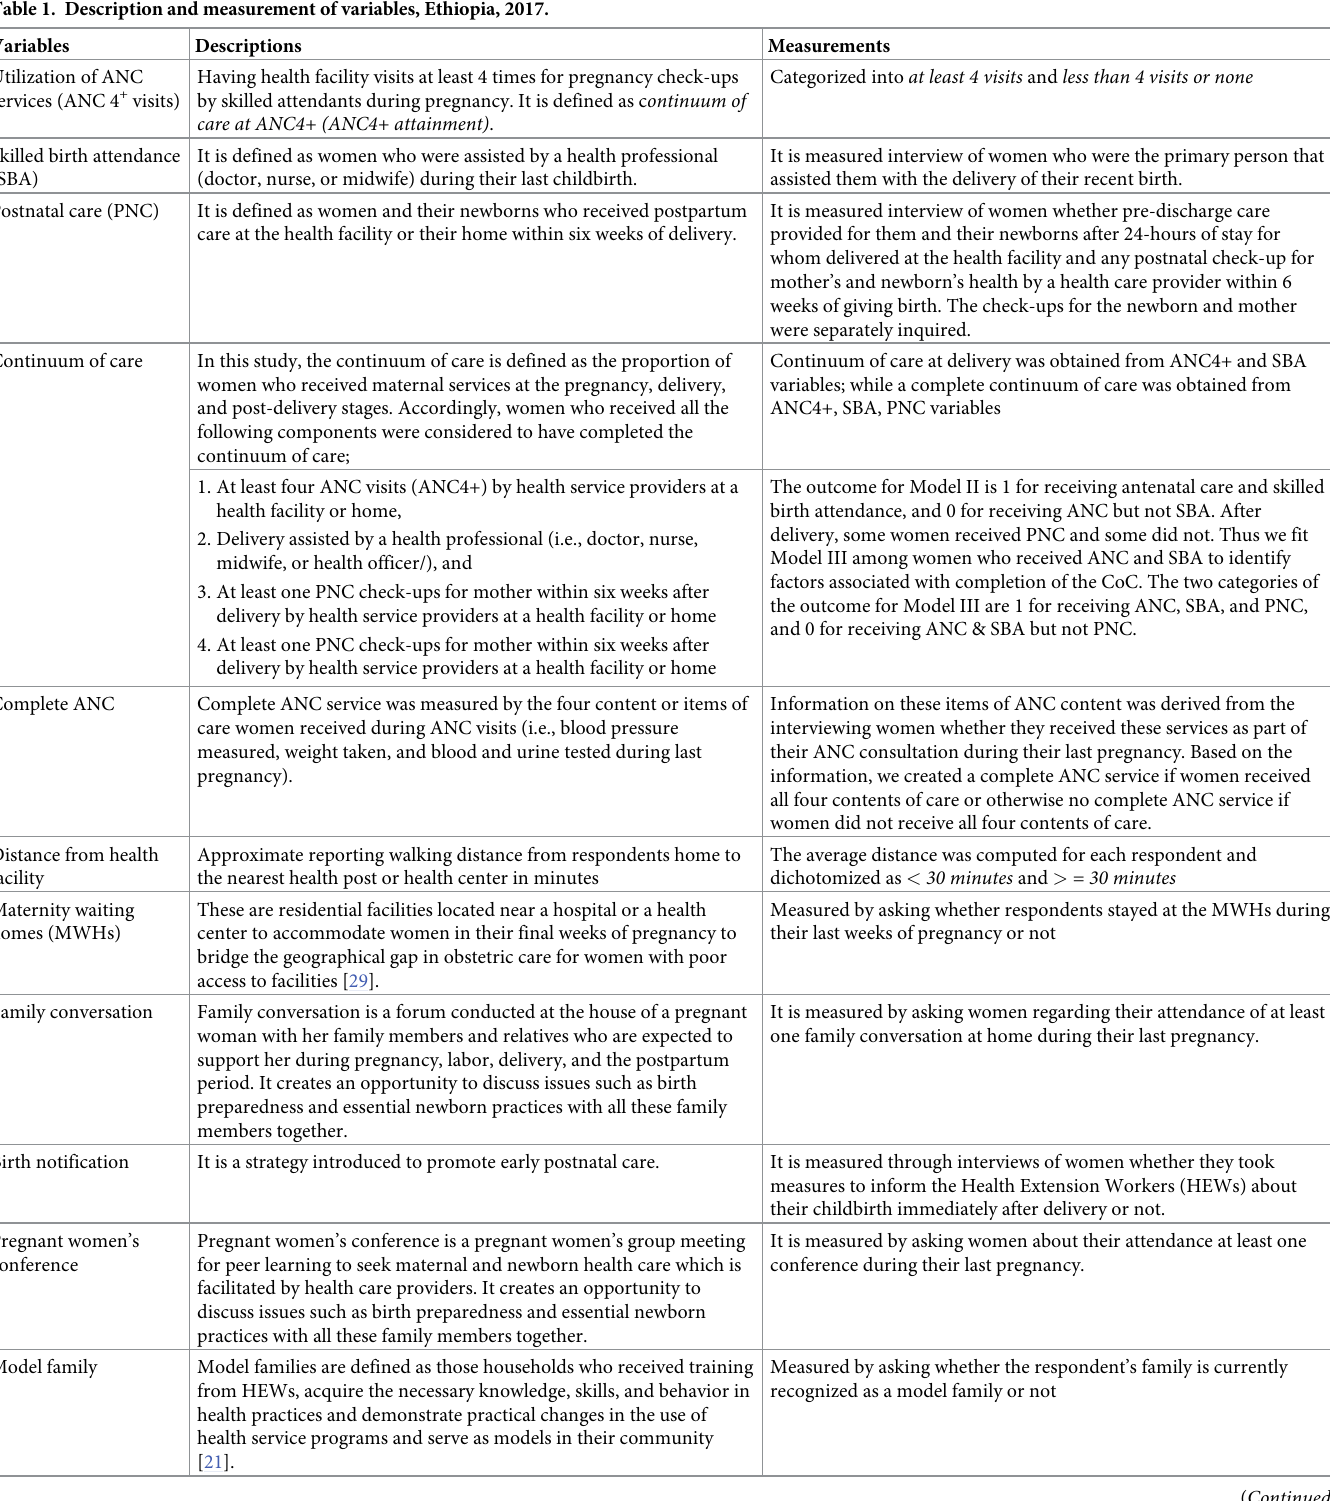
Table 1. Description and measurement of variables, Ethiopia,